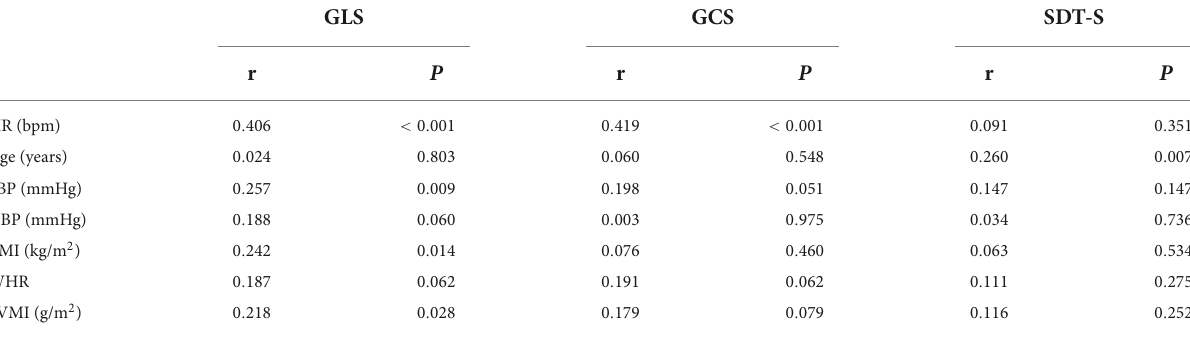
TABLE 6 Univariate analysis of GLS, GCS and SDT-S with Spearman correlation. GLS GCS SDT-S